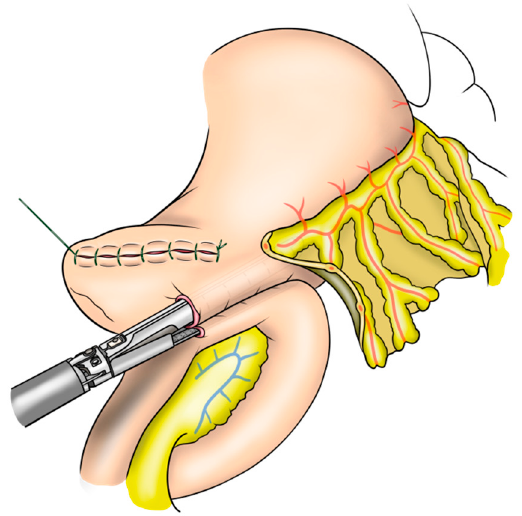
Figure 2. Stapled gastrojejunostomy anastomosis in robotic pancreatoduodenectomy.